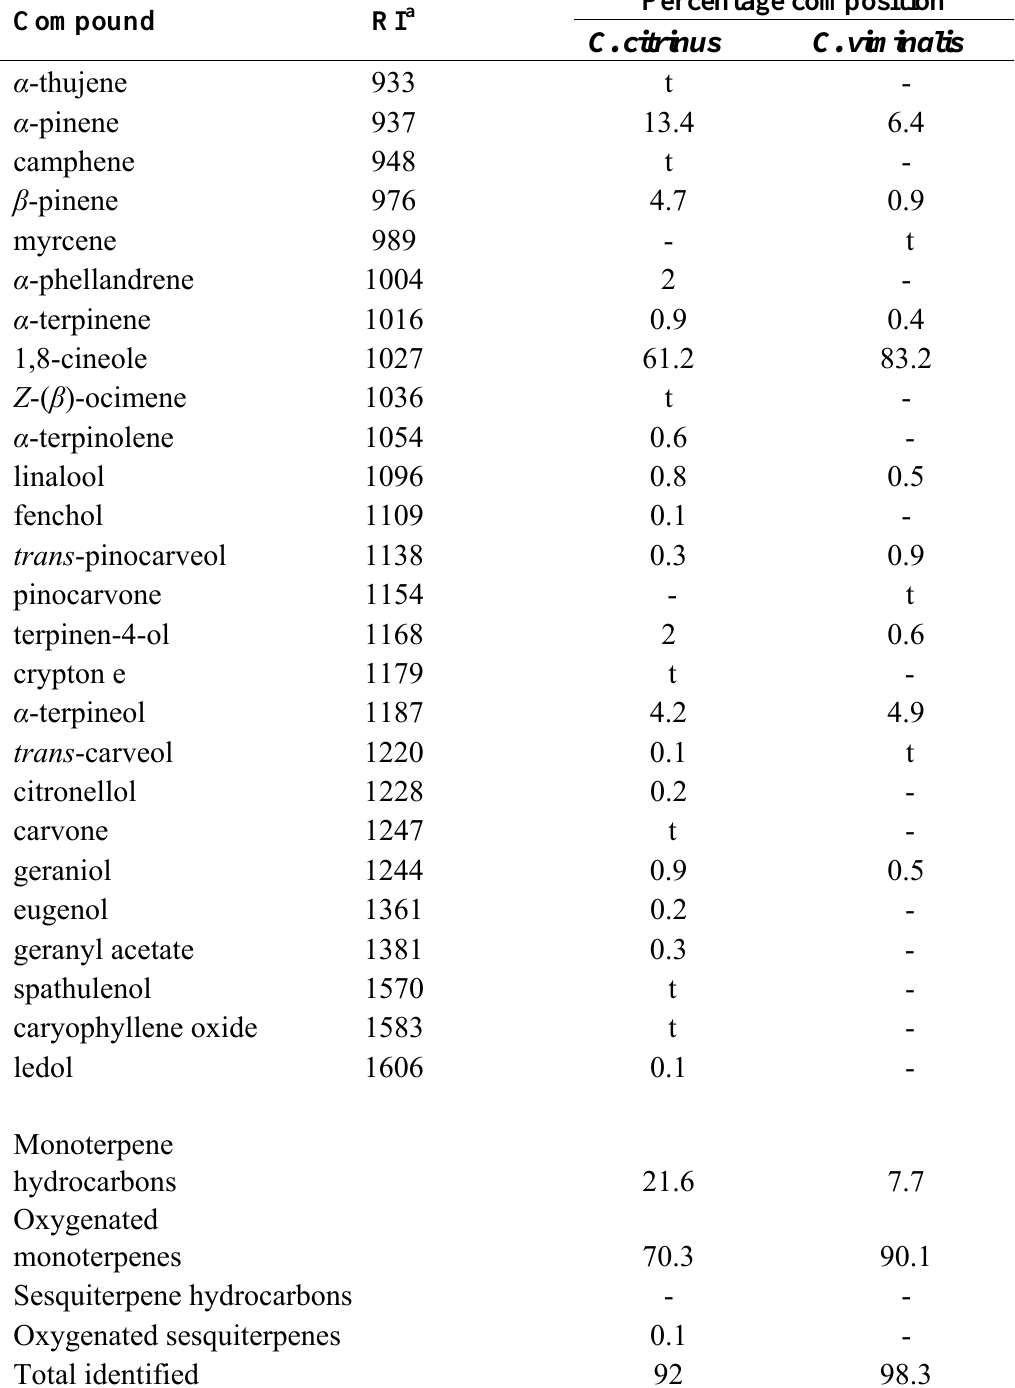
Table 1. Chemical Constituents of essential oil of C. citrinus and C. viminalis leaves.